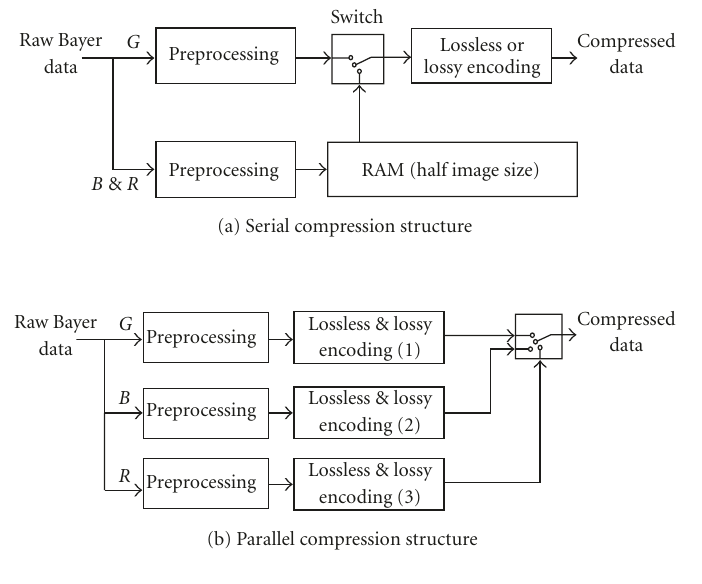
Figure 4: G , B , and R are compressed, respectively.